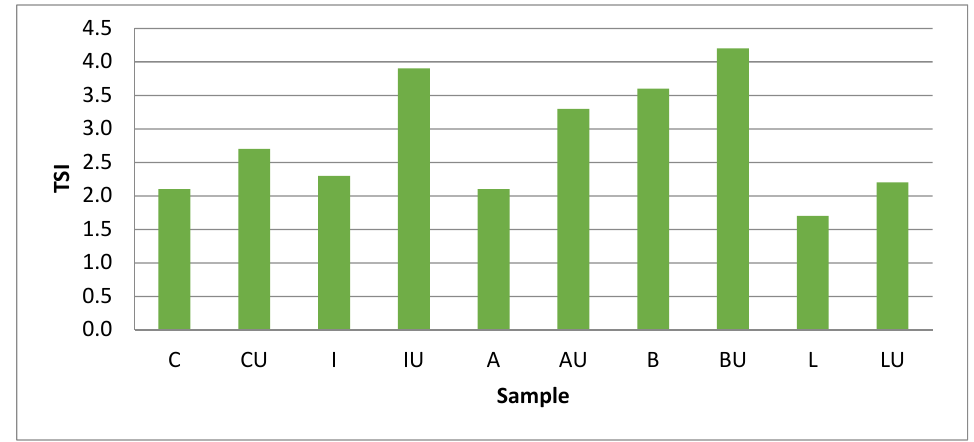
Figure 1. The turbiscan stability index (TSI) of ice cream mixes.